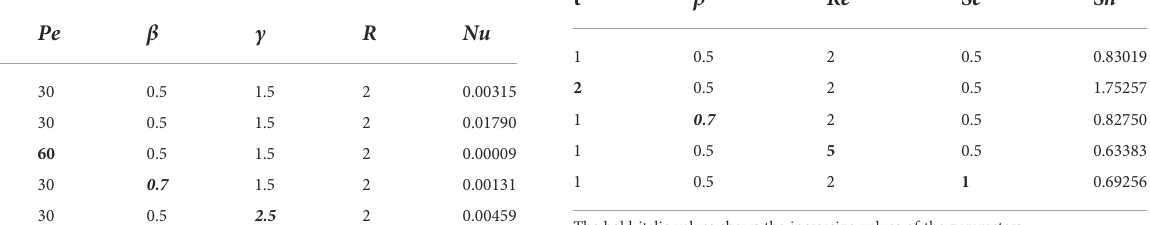
The bold-italic values shows the increasing values of the parameters. TABLE 4 The behaviour of the Nusselt number with the variation of parameters on the right plate.